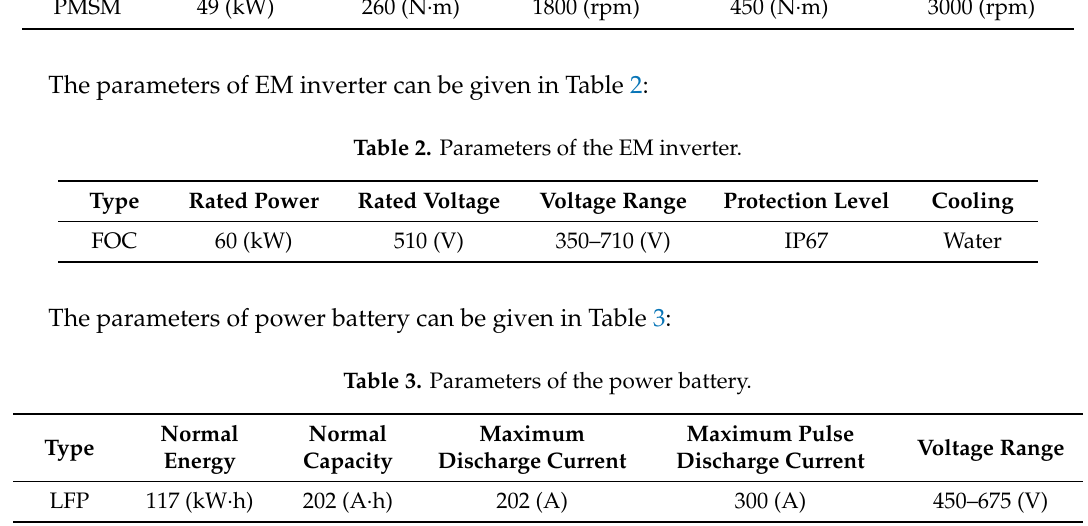
Table 1. Parameters of the EM.